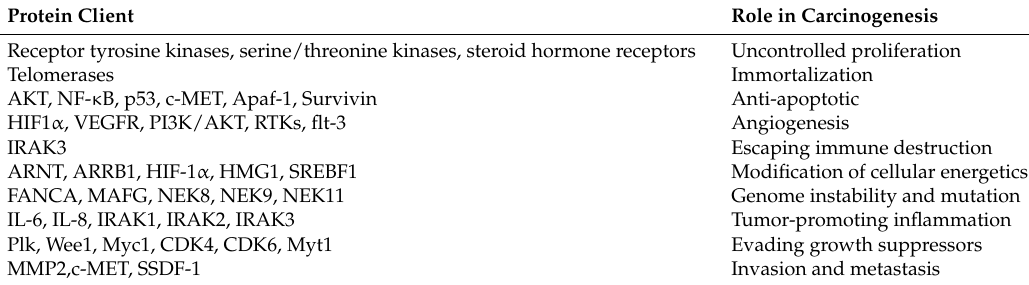
Table 4. HSP90 protein clients and their contribution to carcinogenesis